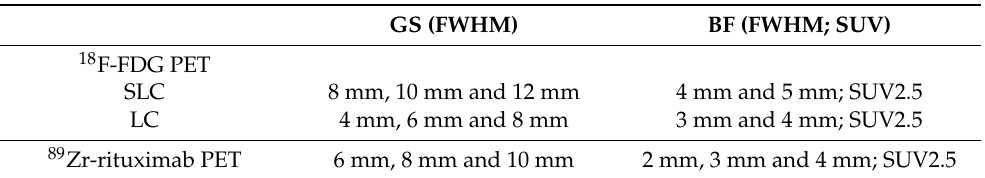
Table 2. Gaussian smoothing (GS) and Bilateral Filtering (BF) settings evaluated for the denoising of the low-count whole-body PET